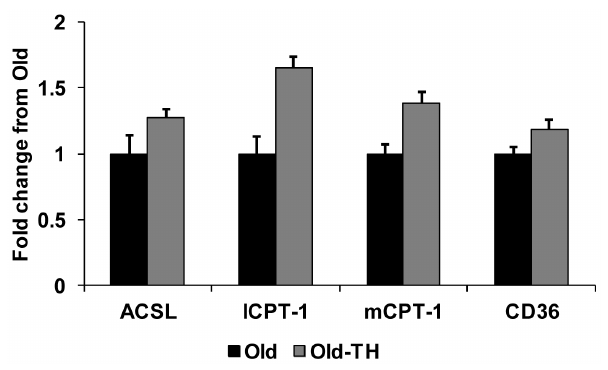
Figure 3. Determination of steady-state mRNA levels for genes involved in fatty acid metabolism. All values are fold difference from Old. N=4 per group. No differences were found between the groups. ACLS, long-chain acyl coenzyme A synthetase; lCPT-1, liver- specific carnitine palmitoyltransferase 1; mCPT-1, muscle-specific